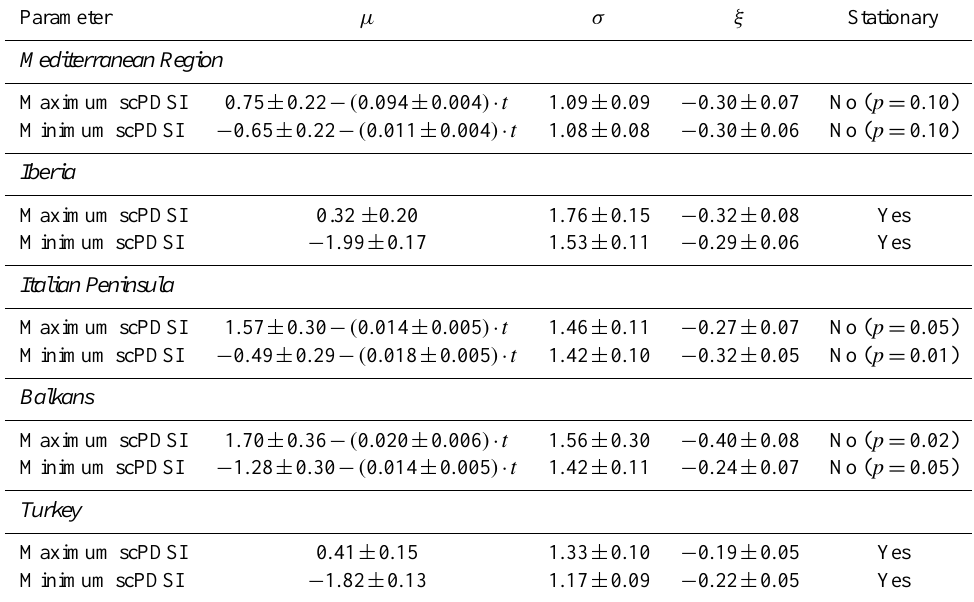
Table 2. GEV distribution parameters for the maximum and minimum scPDSI time series for the entire Mediterranean basin and the four sub-domains.